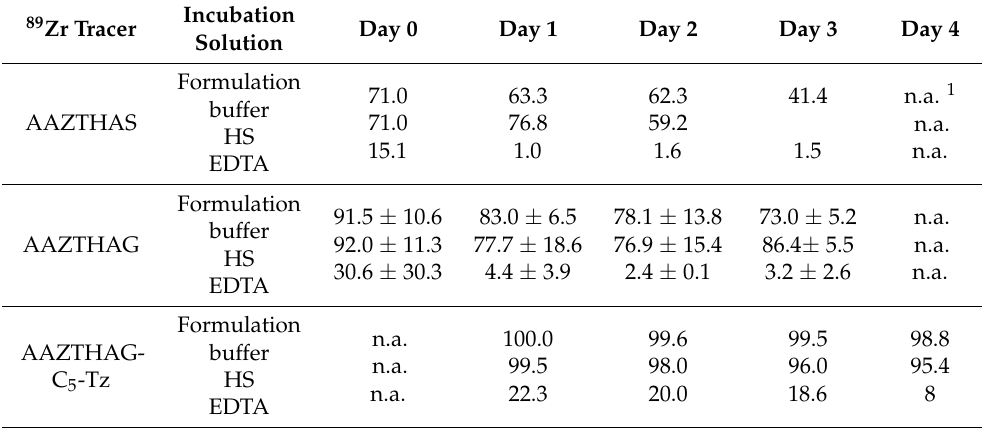
complexed + free 89